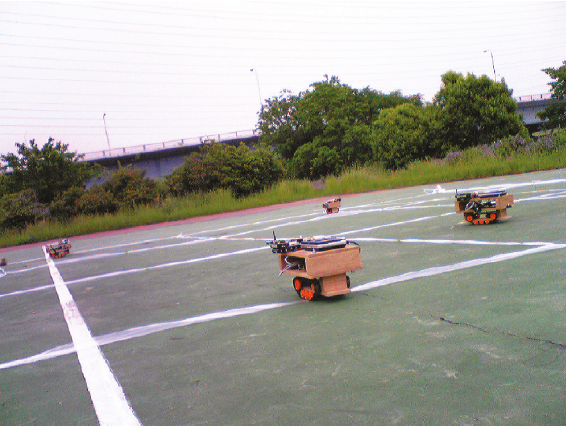
Figure 15: Photograph of the inside of the robot.